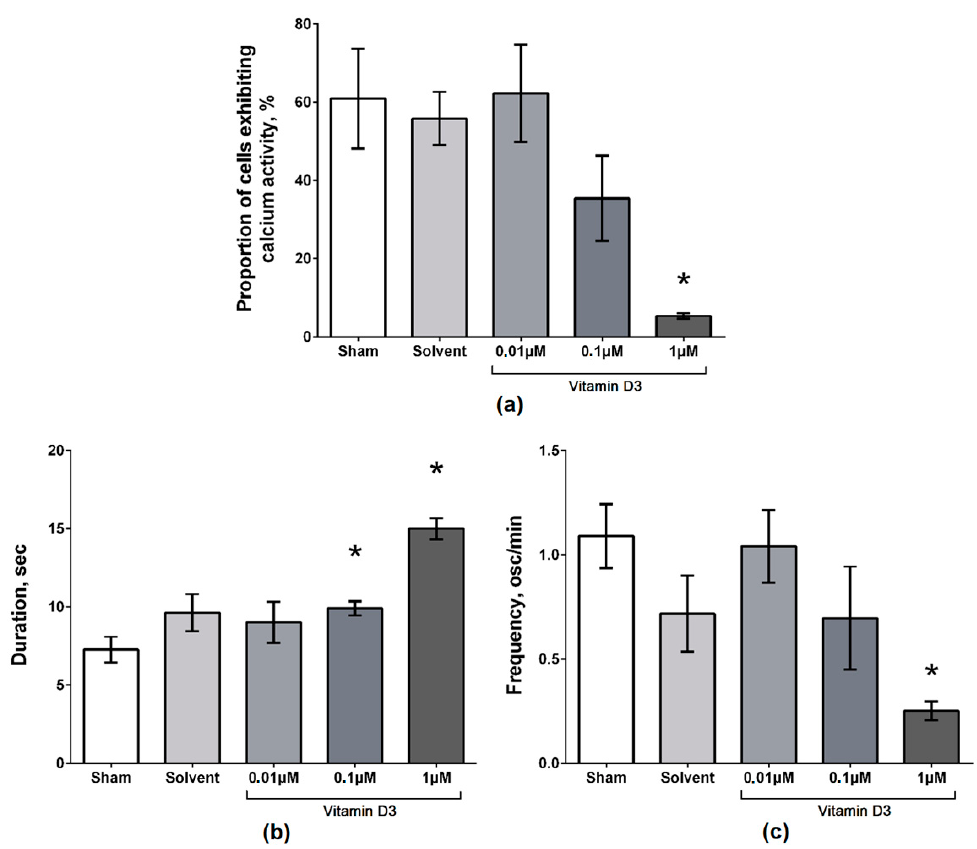
Figure 1. Main parameters of spontaneous calcium activity of primary neuronal cultures on day 7 after vitamin D3 application. ( a ) Proportion of cells exhibiting calcium activity; ( b ) Duration of Ca 2+ oscillations, sec; ( c ) Frequency of Ca 2+ oscillations (osc/min). * versus “Sham”, p < 0.05, the Mann–Whitney test.